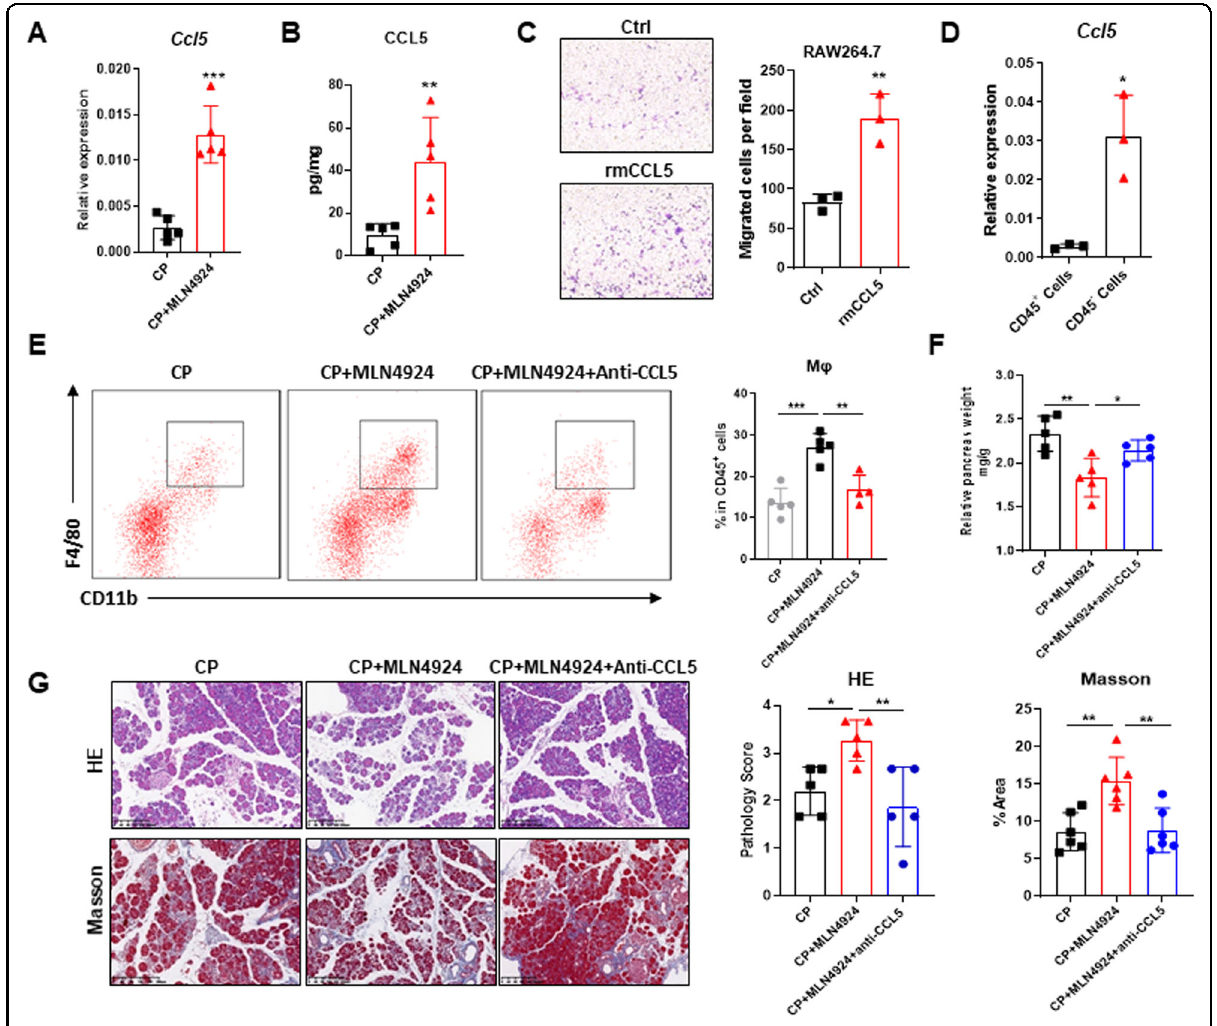
Fig. 4 Neddylation inactivation elevates CCL5 secretion to recruit macrophages. A mRNA expression of Ccl5 in pancreatic tissues. B Protein level of CCL5 in pancreatic lysate supernatants. C The migratory ability of rmCCL5-treated RAW264.7 cells, and the bar graph of migrated cells per fi eld. n = 3. D mRNA expression of Ccl5 in CD45 + and CD45 − cells sorted from the pancreata of MLN4924-treated CP mice. n = 3. E Representative fl ow cytometric fi gures and percentages of macrophages. F Relative pancreas weight (pancreas weight/body weight). G Representative H&E and Masson images of pancreata, and the bar graphs. Scale bar, 200 μ m. A , B , E – G n = 5. C , D n = 3. Data are representative of three independent experiments. *p < 0.05, ** p < 0.01, *** p < 0.001, ns no signi fi